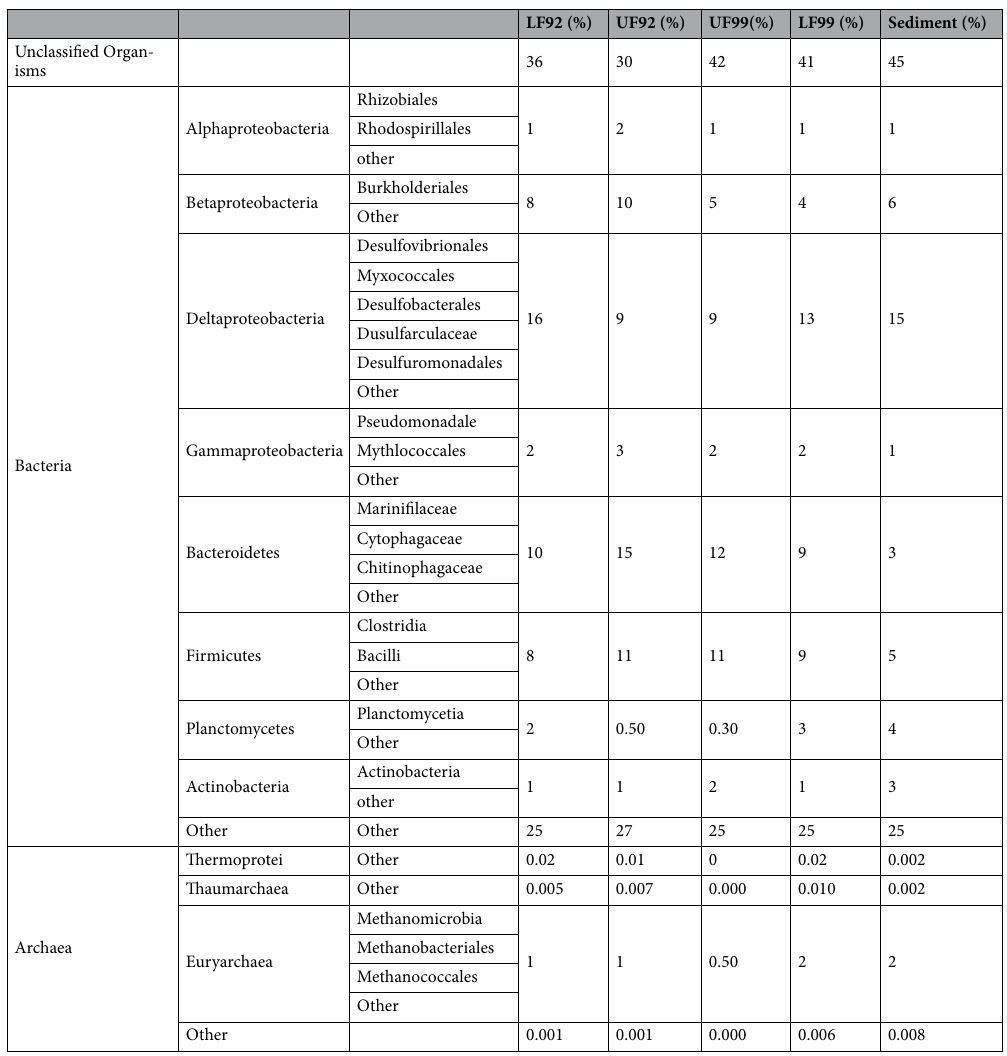
Table 2. Summary of organisms in the anoxic basin. Taxonomic abundances in different samples are based on results from LCA* (RefSeq